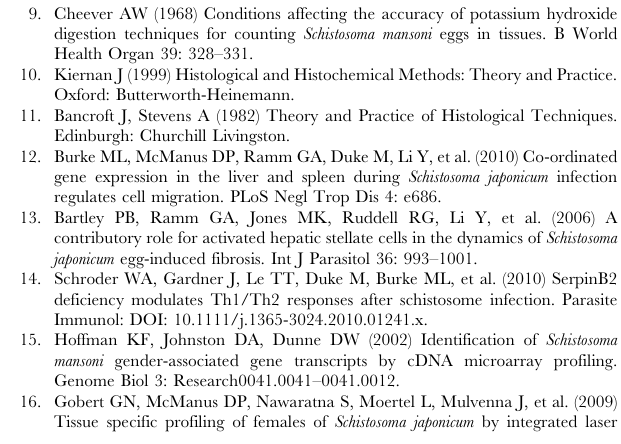
Table S1 Fold changes and standard deviation of all genes (first 21,986) examined by microarray analysis in BALB/c and CBA mice. Data is expressed as fold change relative to uninfected controls of the same strain. This gene list has